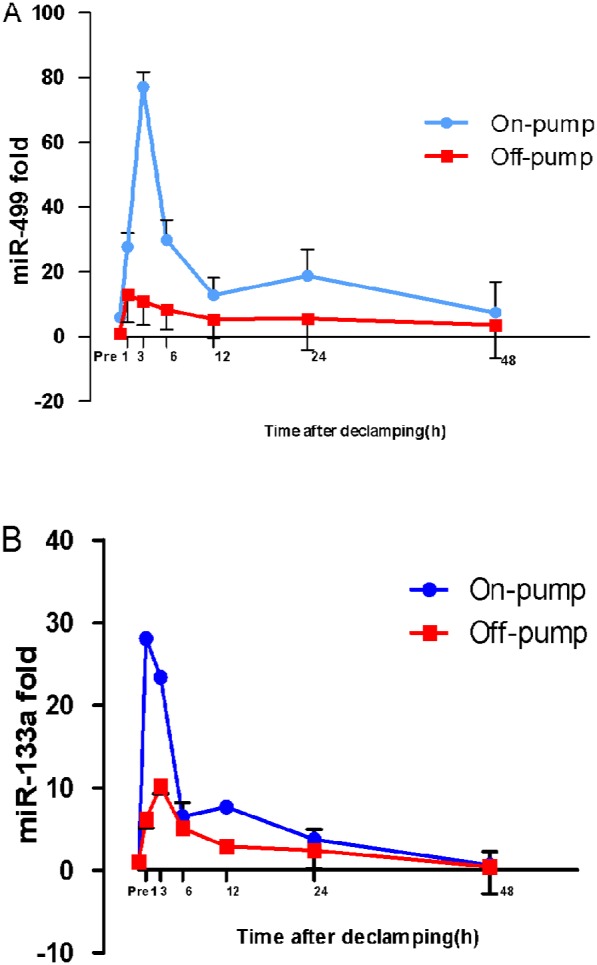
Pump-on and pump-off differences in miR-499 (Figure 3A) and miR-133a (Figure 3B) concentrations.The two curves differ significantly (p<0.0001) for both miR-499 and mIR-133a. In the arrested heart (on-pump) group versus the beating heart (off-pump) group, the miR-499 concentrations were significantly higher at post-declamping hours 1, 3, 6, 12, and 24 (p<0.0001), while the miR-133a concentrations were significantly higher at hours 1, 3, and 12 (p<0.0001). All mean±standard deviation levels are expressed as fold increase (2−ΔΔCt scale) relative to those in the preoperative control.